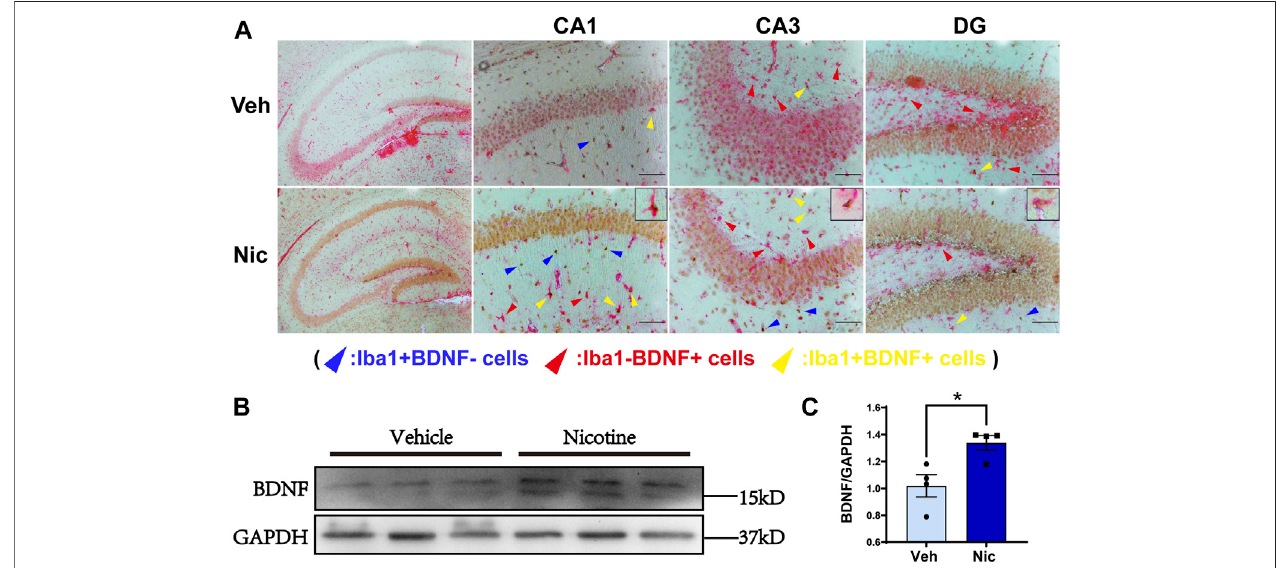
FIGURE 6 | Maternal nicotine increased the number of microglia Iba1 and BDNF double-positive staining cells. Low magni fi cation ( × 100) of the hippocampal coronal sections ofvehicleoffspring and nicotine offspring ( A , left) at postnatal day 20, respectively. Iba1-positive cells weremarked withDAB (brown) and BDNF-positive cells were marked with AP (red). Increased number of Iba1-positive, BDNF-positive, and Iba1-positive BDNF-positive cells were observed in DG, CA1, CA3. The yellow arrowhead represents Iba1-positive BDNF-positive, the red arrowhead represents Iba1-negative BDNF-positive, and the blue arrowhead represents Iba1-positive BDNF-negative (A) . BDNF protein level was distinctly increased in nicotine offspring, as compared to vehicle offspring (B, C) . ** p < 0.01; Scale bar: 100 μ m (A, B); 50 μ m (C). all data are means ±